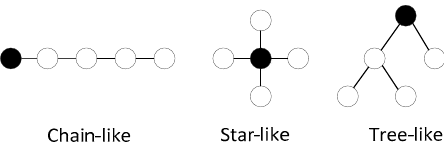
Figure 2. Three types of interdependency.